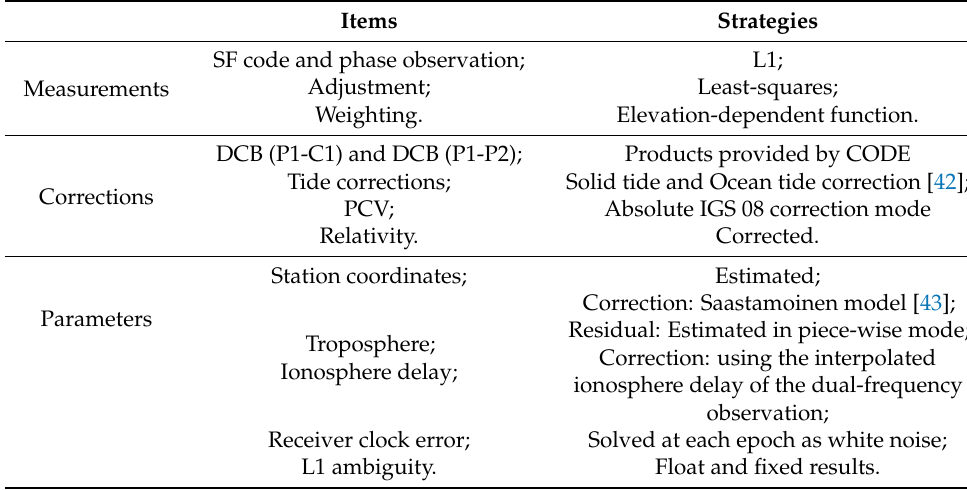
Table 1. Adopted models and strategies for the